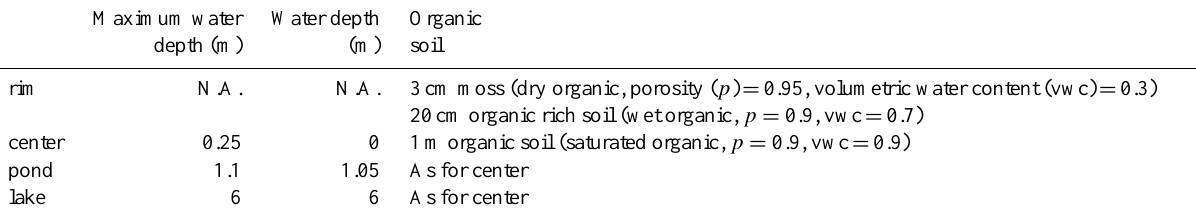
Table 2. Water and organic soil configurations used in the model for the different test sites (N.A. not available). Maximum